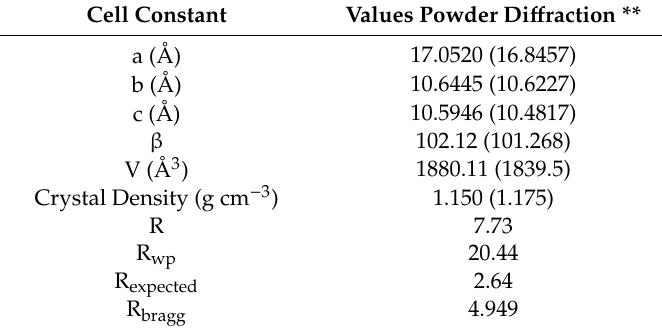
Table 1. Crystal data for ( E )-2-{[(2-aminopyridin-2-yl)imino]-methyl}-4,6-di- tert -butyl-phenol ( L1 ) compound